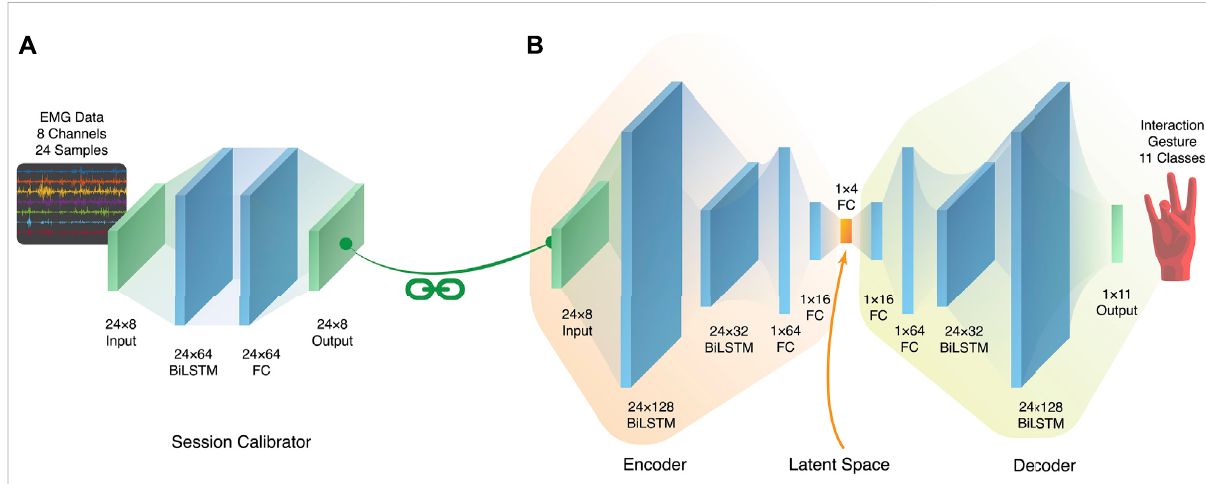
FIGURE 5 (A) Thesession-calibratorarchitecture,whichpreservestheshapeoftheEMGwindow. (B) Themainencoder-decoderLSTMarchitectureused for training. The symmetry and bottleneck mimic that of a standard